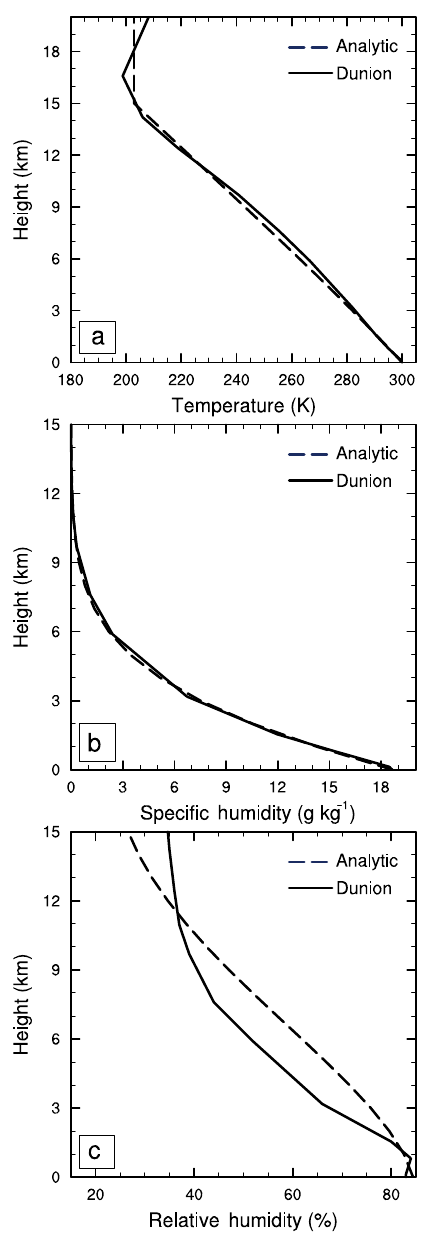
Figure 2. Comparison of the analytic vertical profiles at 300K to the observed Dunion (2011) moist tropical soundings of (a) temper- ature, (b) specific humidity, and (c) relative humidity (over liquid).